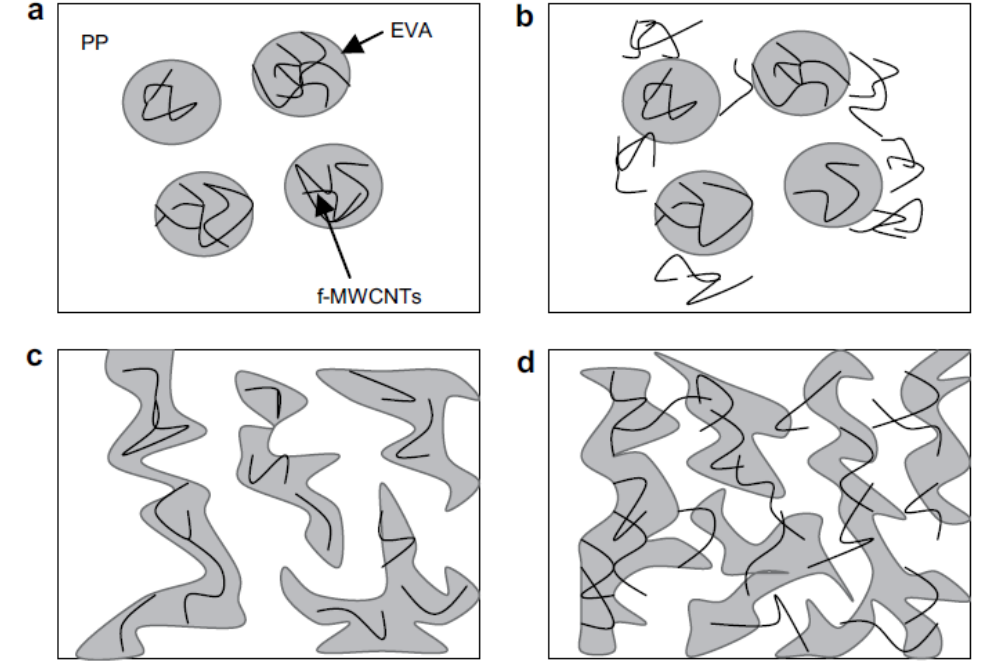
Figure 55. Schematic representations of the dispersion states of f-MWCNTs in PP/EVA blends. (a): f-MWCNTs tend to aggregate in dispersed EVA phase in PP/EVA (80/20) at low load; (b): f-MWCNTs migrate to PP phase and form a local ‘‘single-network structure’’ at high load; (c): f-MWCNTs exhibit good dispersion in continuous phase of EVA in PP/EVA (60/40) at low load and (d): f-MWCNTs form the network structure in the whole blend. Reproduced with permission from ref.